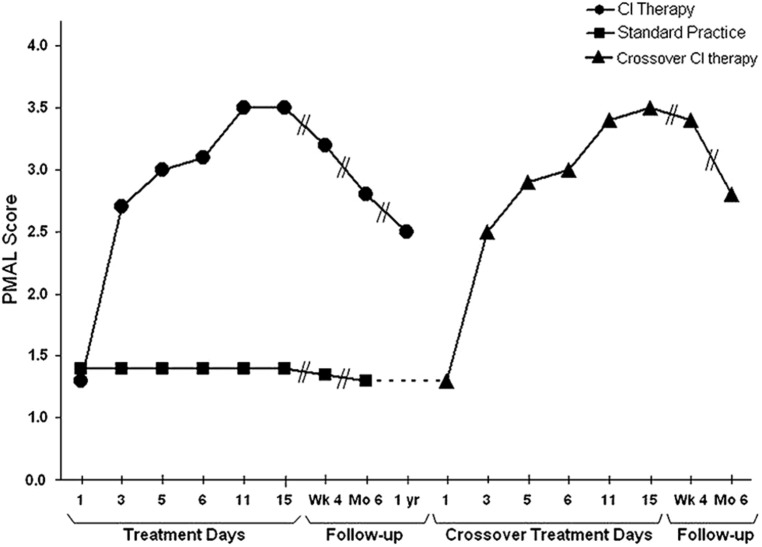
Spontaneous use of the more impaired arm (Pediatric Motor Activity Log score) of young (2–6 years) children with hemiparetic CP receiving Constraint-Induced Movement therapy or standard occupational therapy. Data for the Constraint-Induced Movement therapy group are shown before and during treatment and 1, 6, and 12 months after treatment. Data for the control subjects are shown at corresponding times for 6 months after treatment, at which time they were crossed over to Constraint-Induced Movement therapy. After crossover data are shown for treatment and 1 and 6 months afterward. The data are similar to those for adults shown in Figure 1. For both the children given CI therapy first and those given the intervention after crossover, the amount of spontaneous use of the more affected arm in the ADL in the real-world environment increased from approximately 15% compared to use of the less affected arm to approximately 65%. Reprinted from Taub et al. (2011).